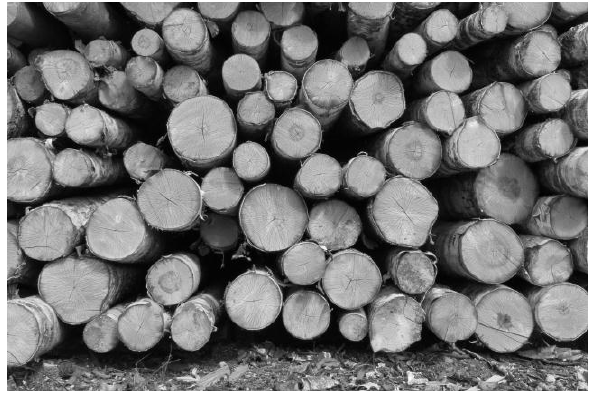
Figure 3. Left image of the controlled stack part Then left image orthotransformation to some reference plane Z is performed. It gives scaled map of the front side of a log stack with known scale factor, but the dimensions of log ends could not be found from this image because really log ends do not belong to orthotransformation plane.